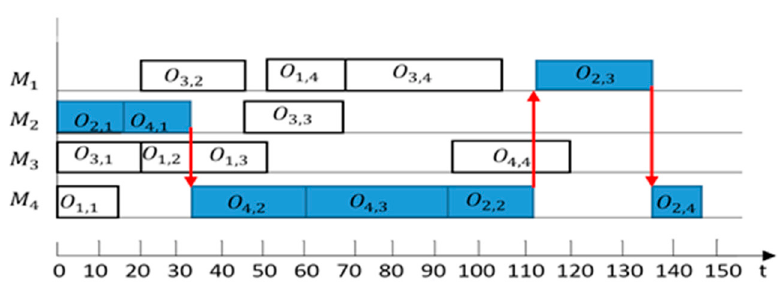
Figure 5. Disjunction graph of flexible job shop scheduling.